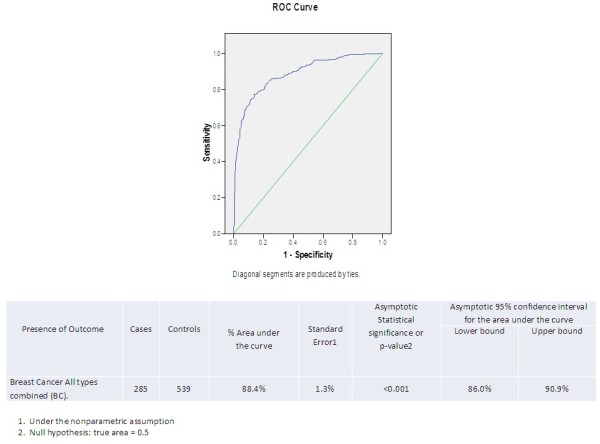
DRC detecting the presence of breast cancer ROC Curve (285 cases and 539 Controls).